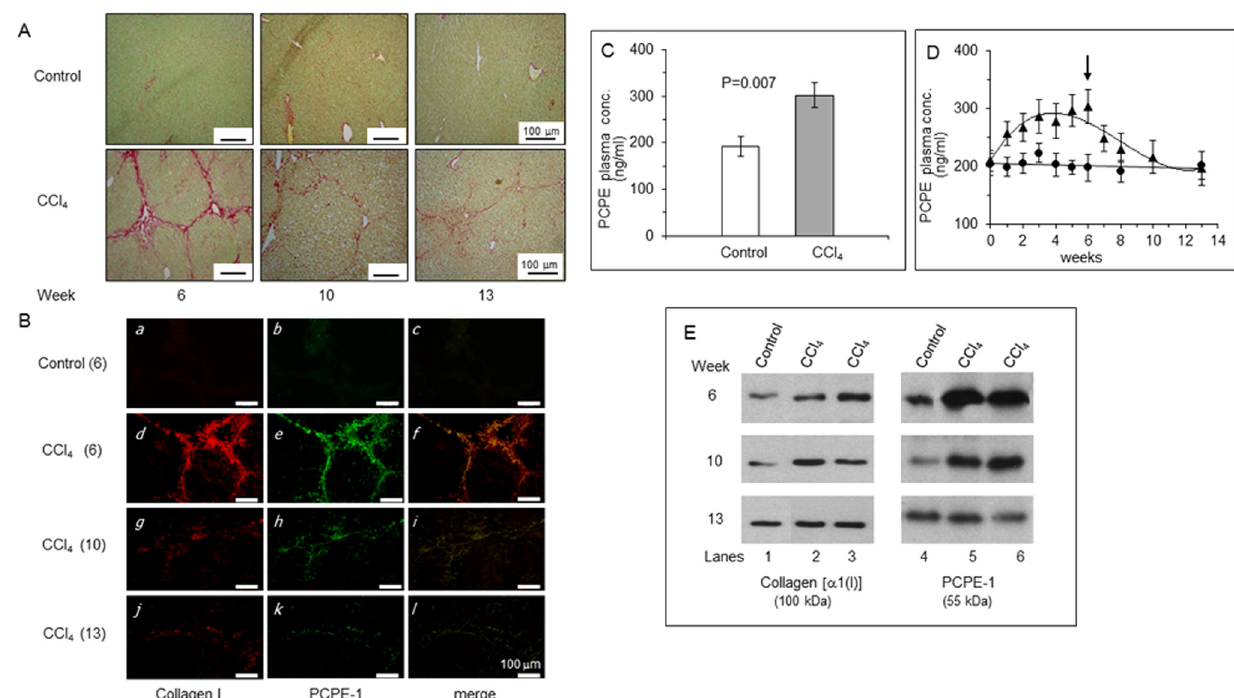
Fig 5. Plasma concentrations of PCPE-1 reflect the progression of liver fibrosis in CCl 4 -treated mice. C57/BL/6 mice were given CCl 4 for 6 weeks and then remained untreated for 7 additional weeks. Liver fibrosis was assessed at the indicated times by Sirius red staining, immunoblotting, and immunofluorescence analyses. Plasma concentrations of PCPE-1 were determined by the sandwich ELISA at the indicated time points. (A ) Sirius Red staining of liver sections from mice euthanized at weeks 6, 10 and 13. Each panel shows results for a single randomly selected mouse from the indicated group. Red , collagen; Green , non-collagenous proteins. (B )Immunofluorescence for type I collagen and PCPE-1 in liver sections from CCl 4 -treated and control mice at different times (given in brackets as the number of weeks). Each panel displays results for a single randomly selected mouse from the indicated group. Collagen type I (red) and PCPE-1 (green) were detected using Rhodamine- and Cy2-conjugated secondary antibodies at 488 and 580 nm, respectively. (C) Plasma concentrations of PCPE-1 after 6 weeks of CCl 4 administration are significantly higher than those of control mice (n = 12). (D ) Plasma concentrations of PCPE-1 in CCl 4 -treated ( ▲ ) and control ( ● ) mice as a function of time. Arrow, termination of CCl 4 treatment. Results are presented as mean ± SD. (n at weeks 0 to 6 = 12; n at weeks 7 – 10 = 9; n at week 13 = 6). (E) Immunoblot evaluating collagen I and PCPE-1 content in liver extracts from CCl 4 -treated and control mice at weeks 6, 10 and 13. Samples from a single control mouse and two CCl 4 -treated mice (all randomly selected) were analyzed. The amounts of protein applied on each lane were 4 and 36 μ g for collagen and PCPE-1 detection, respectively.